Question: What does this figure show? Answer in one sentence.
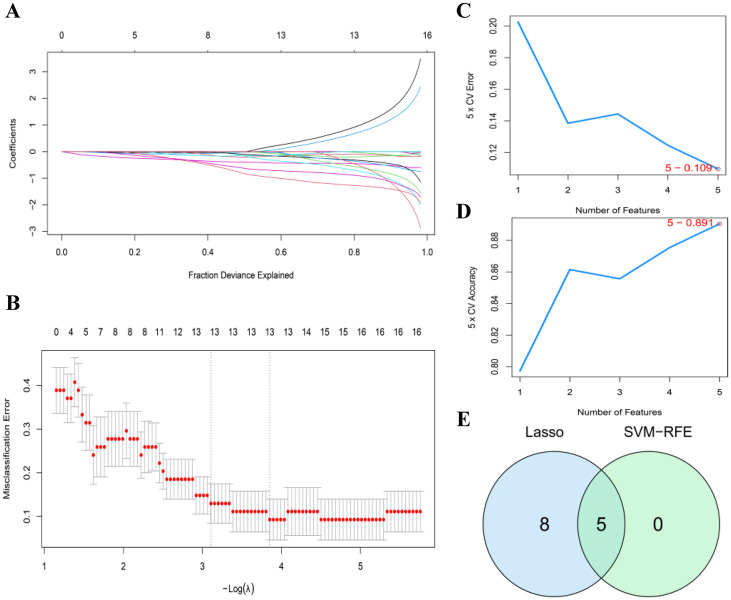
Answer: Machine-learning prioritization of hub genes. (A) LASSO coefficient profiles. (B) LASSO cross-validation curve. (C) SVM-RFE feature-selection process. (D) SVM-RFE model-accuracy curve. (E) Intersection of genes retained by LASSO and SVM-RFE.